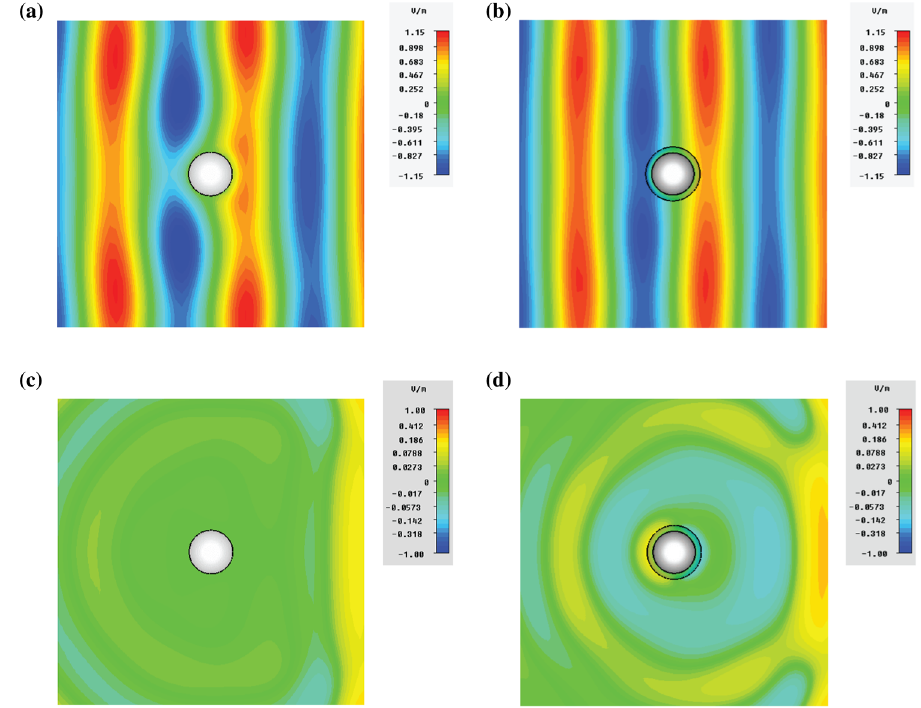
FIG. 2. Top row: Time snapshot of the electric field distribution on the H plane for monochromatic plane-wave excitation at the design wavelength (cid:1) c ¼ 300 nm . (a) Uncloaked PEC sphere and (b) PEC sphere covered by a plasmonic cloak. Bottom row: Time snapshot of the electric field distribution on the H plane for a Gaussian-pulse plane-wave excitation with bandwidth indicated by the vertical dashed lines in Fig. 1(b), after having just passed the object. (c) Uncloaked PEC sphere and (d) PEC sphere covered by a plasmonic cloak. The geometries of the sphere and the cloak are the same as in Fig.